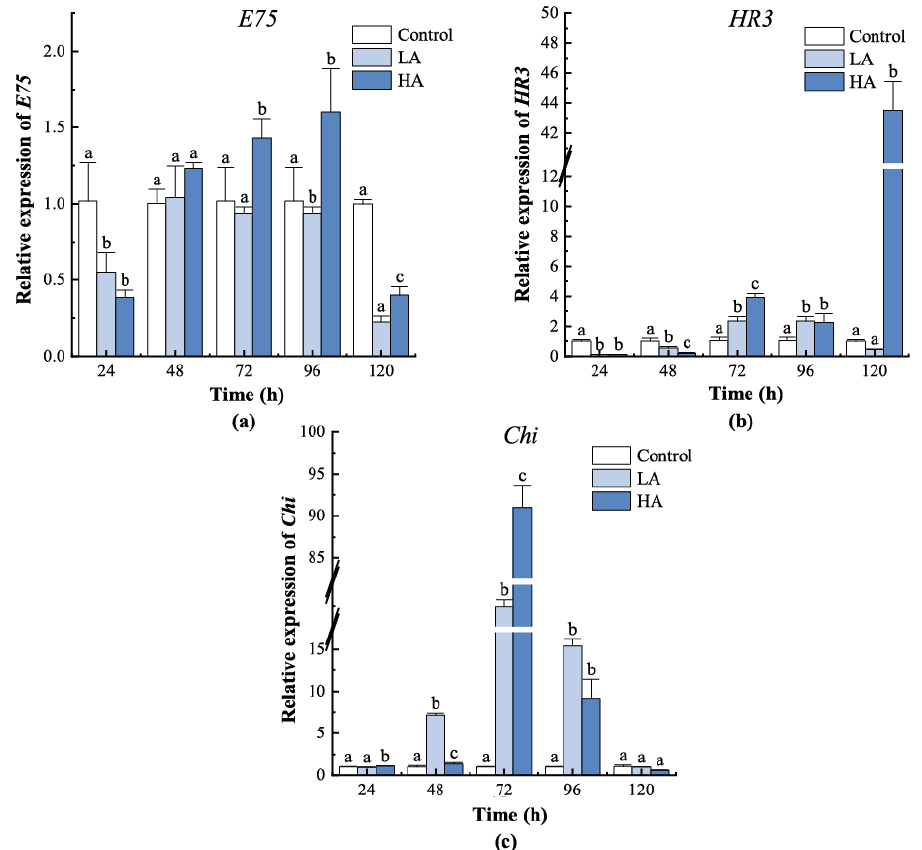
Figure 6. Gene expression pattern of downstream regulators in juvenile crabs exposed to ammonia nitrogen stress. ( a ) E75 , ( b ) HR3 , and ( c ) Chi . At the same time, the letters indicate significant differences between experimental groups ( p < 0.05).